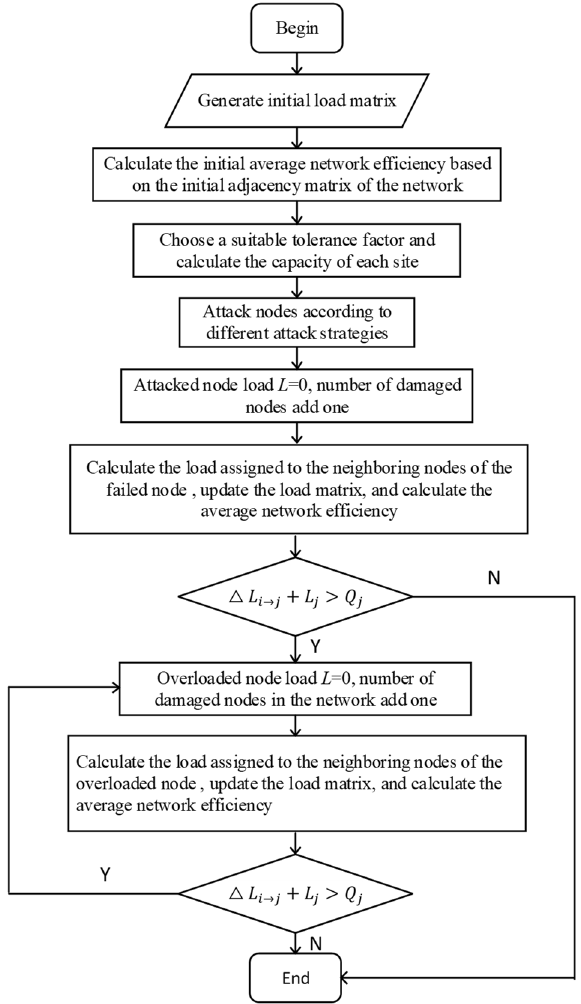
Figure 7. Cascading failure simulation.